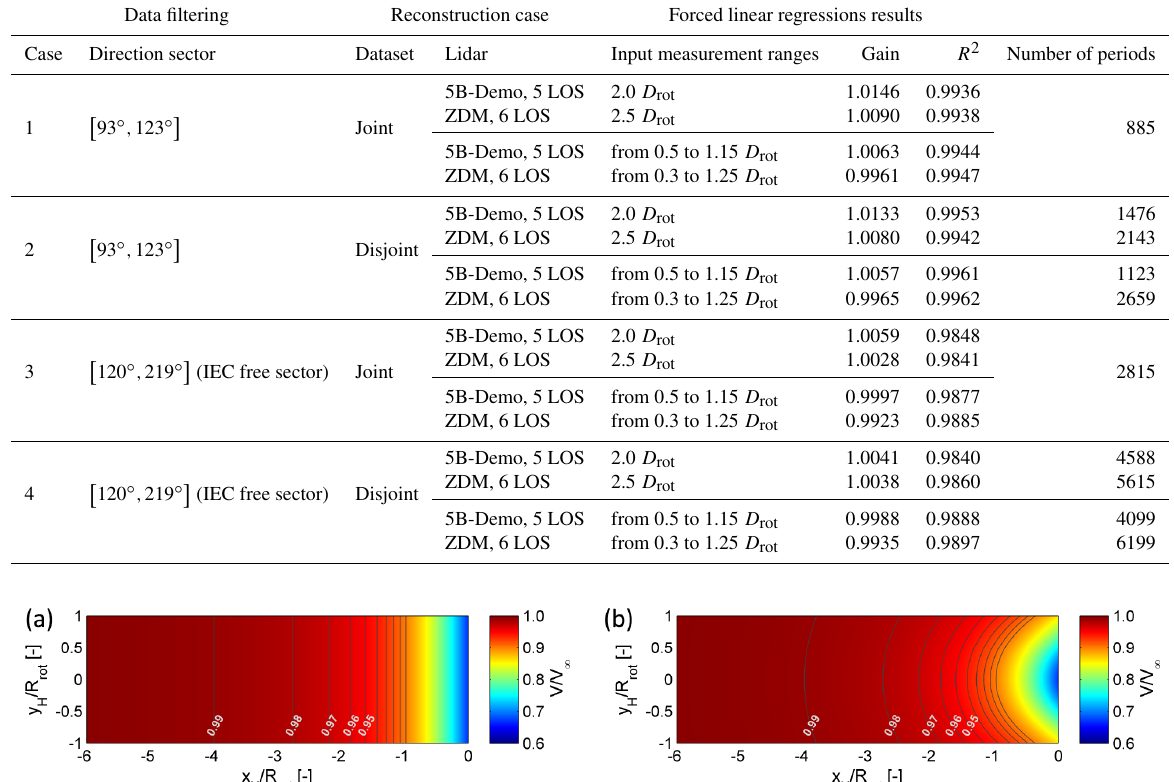
Table 2. Summary of comparison results between lidar-estimated and mast-measured horizontal wind speed, at hub height. Data filtering